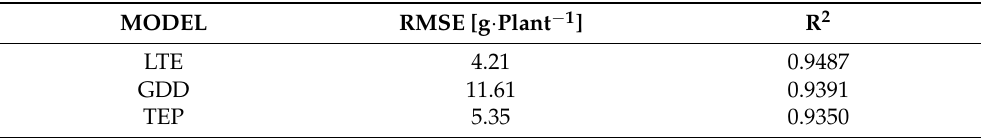
Figure 3. Comparison of observed and simulated values of shoot dry weight. Note: This line represents the situation when the observed and simulated values coincide exactly. Comparing the simulated values with the line provides a better view of the simulation. Table 2. The RMSE in each model.